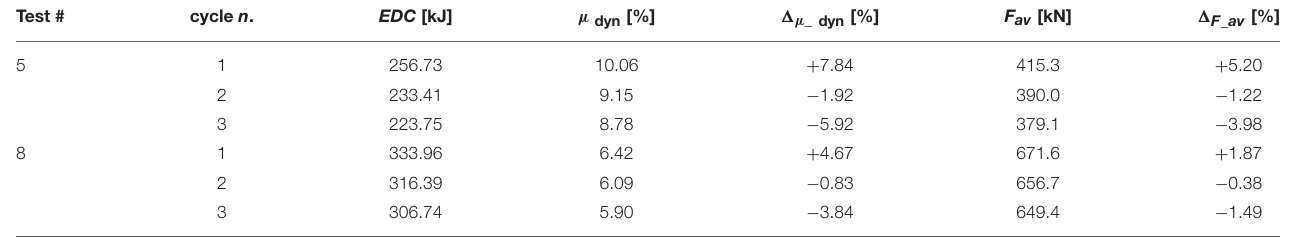
TABLE 4 | Hysteretic parameters corresponding to two tests with friction